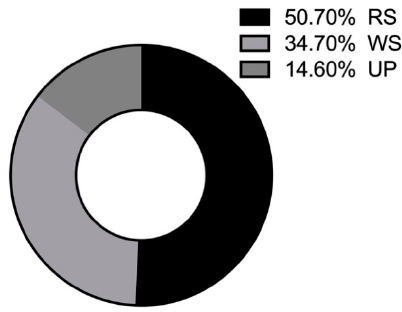
Figure 11. Weight of each factor.